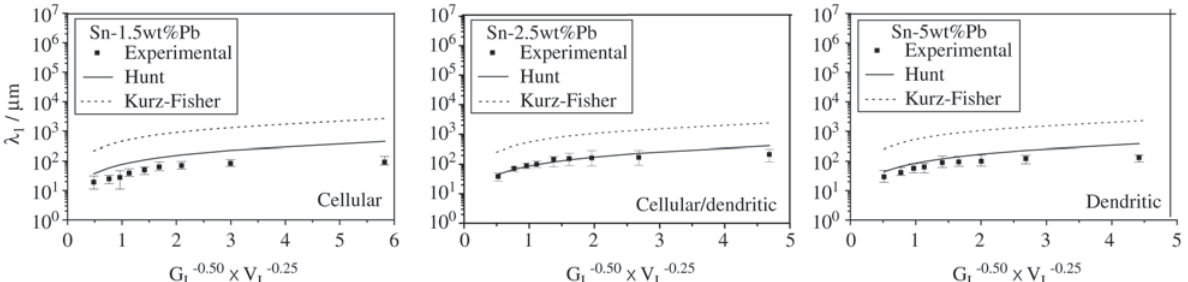
Figure 6. Comparison between theoretical and experimental values of cellular/dendritic spacings